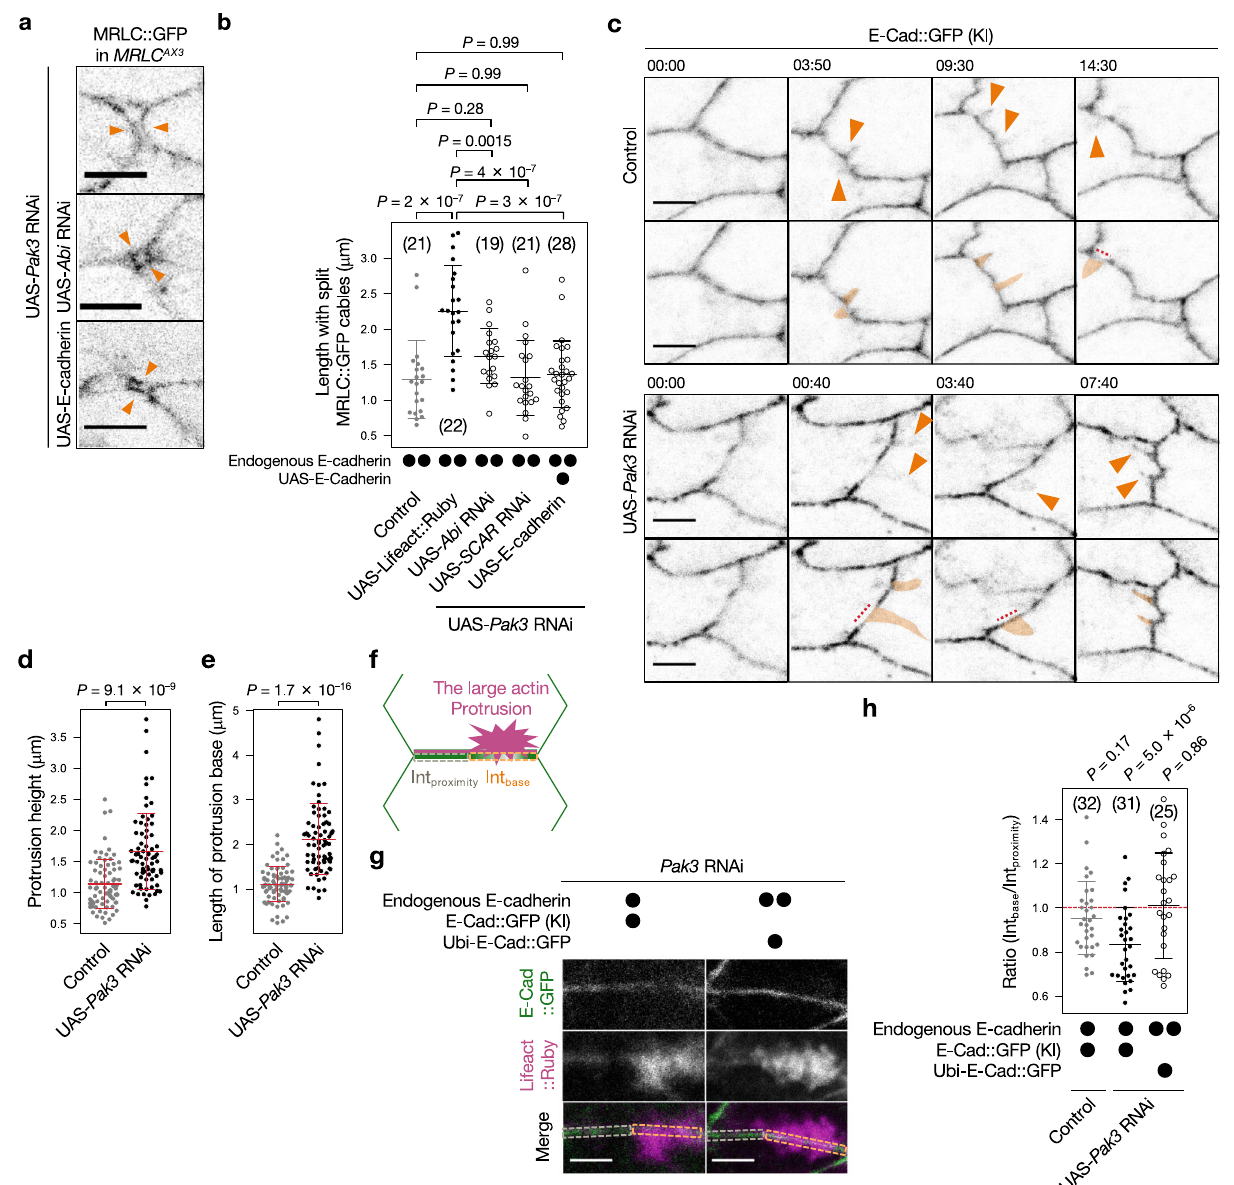
Fig. 4 Decrease in E-cadherin levels at junctions mediates the mislocalization of myosin II cables. a Representative images of split MRLC::GFP cables (orange arrowheads) at junctions. Scale bar, 5 μ m. b Mean± S.D. of the lengths of junctions when the MRLC::GFP cables initiated splitting. Dots indicate the copy number of each E-cadherin allele. Parentheses, the number ( n ) of examined junctions from 3 – 6 biologically independent pupae per genotype. P - value by two-tailed Tukey ’ s test. c Representative magni fi ed time-lapse images (duplicated) of E-Cad::GFP at junctions from >3 independent experiments. E-Cad::GFP-positive protrusions are indicated by arrowheads (top) or masked (bottom), respectively. Broken lines indicate the local decrease in E-Cad::GFP levels at the bases of the protrusions. Scale bar, 3 μ m. d , e The mean ± S.D. of the height and width (length of the base) of E-Cad::GFP-positive protrusions. n = 77 (Co n trol) or 74 (Pak3 RNAi) protrusions from 5 (Control) and 7 (Pak3 RNAi) biologically independent pupae ( c – e ). P -value by unpaired t -test. f A schematic illustration of the junctional regions (boxed with broken lines) for measuring the mean E-Cad::GFP levels at the base of small actin protrusions in the control cells or the large protrusions in Pak3 RNAi cells (orange), and its proximity (gray). g Images of junctions with E-Cad::GFP and Lifeact::Ruby in Pak3 RNAi cells. Dots indicate the copy number of each E-cadherin allele. Broken boxes indicate quanti fi ed areas; each color corresponds with the colors in ( f ). Scale bar, 3 μ m. h Mean ± S.D. of the ratio of Int base and Int proximity per junction. Parentheses, the number ( n ) of small (control) or the large (Pak3 RNAi) actin protrusions examined from 4 (the control and Pak3 RNAi) and 3 (Pak3 RNAi with Ubi-E-Cad::GFP) biologically independent pupae. Dots indicate the copy number of each E-cadherin allele. P -value by one-sample t -test with a test value of 1. Genotypes: a , b MRLC AX3 /Y;MRLC-MRLC::GFP/ + ;AbdB-Gal4, UAS-H2B::ECFP/ + (Control), MRLC AX3 /Y;MRLC-MRLC::GFP/UAS-Lifeact::Ruby;AbdB-Gal4, UAS-H2B::ECFP/UAS-Pak3 RNAi , MRLC AX3 /Y;MRLC-MRLC::GFP/ UAS-Abi RNAi;AbdB-Gal4, UAS-H2B::ECFP/UAS-Pak3 RNAi , MRLC AX3 /Y;MRLC-MRLC::GFP/UAS-SCAR RNAi;AbdB-Gal4, UAS-H2B::ECFP/UAS-Pak3 RNAi , and MRLC AX3 /Y;MRLC-MRLC::GFP/UAS-E-cadherin;AbdB-Gal4, UAS-H2B::ECFP/UAS-Pak3 RNAi ; c – e + /Y;E-Cad::GFP;AbdB-Gal4, UAS-H2B::ECFP/ + (Control) and + /Y;E-Cad::GFP (KI);AbdB-Gal4, UAS-H2B::ECFP/UAS-Pak3 RNAi ; g , h + /Y;E-Cad::GFP (KI)/UAS-Lifeact::Ruby;AbdB-Gal4/ + (Control), + /Y;E-Cad::GFP (KI)/UAS-Lifeact::Ruby;AbdB-Gal4/UAS-Pak3 RNAi , and + /Y;Ubi-E-Cad::GFP/UAS-Lifeact::Ruby;AbdB-Gal4/UAS-Pak3 RNAi . Source data are provided as a Source data fi